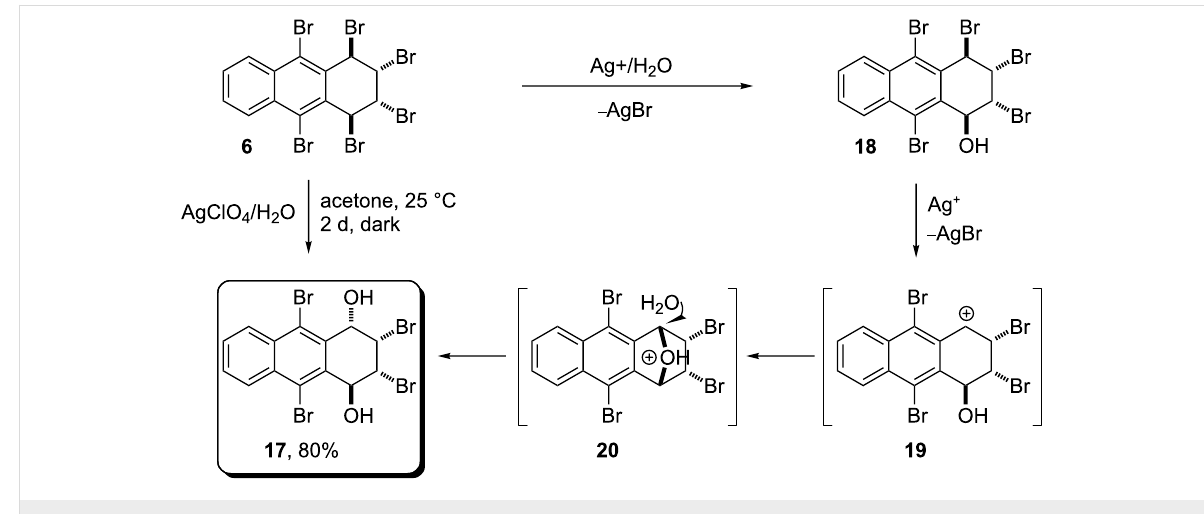
Scheme 4: The formation mechanism for dihydroxy 17 .